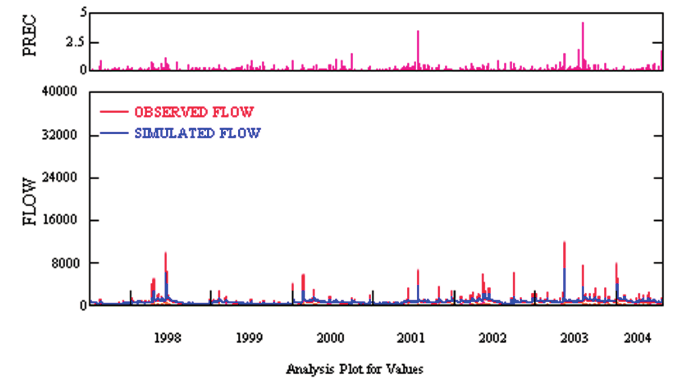
Figure 5. Watershed hydrological model calibration and